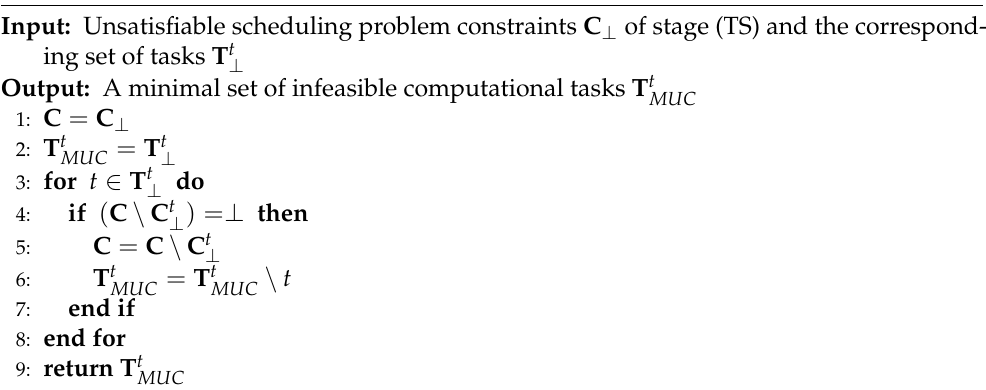
Algorithm 1 Set-based Deletion Filter for stage